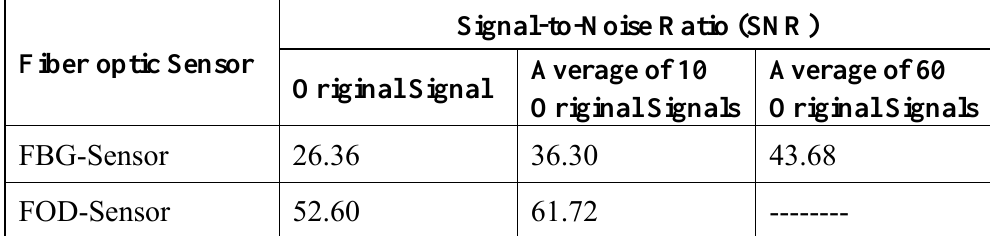
Table 2. Signal-to-noise ratio of original and averaged guided wave signals acquired by different fiber optic sensors from the intact CFRP